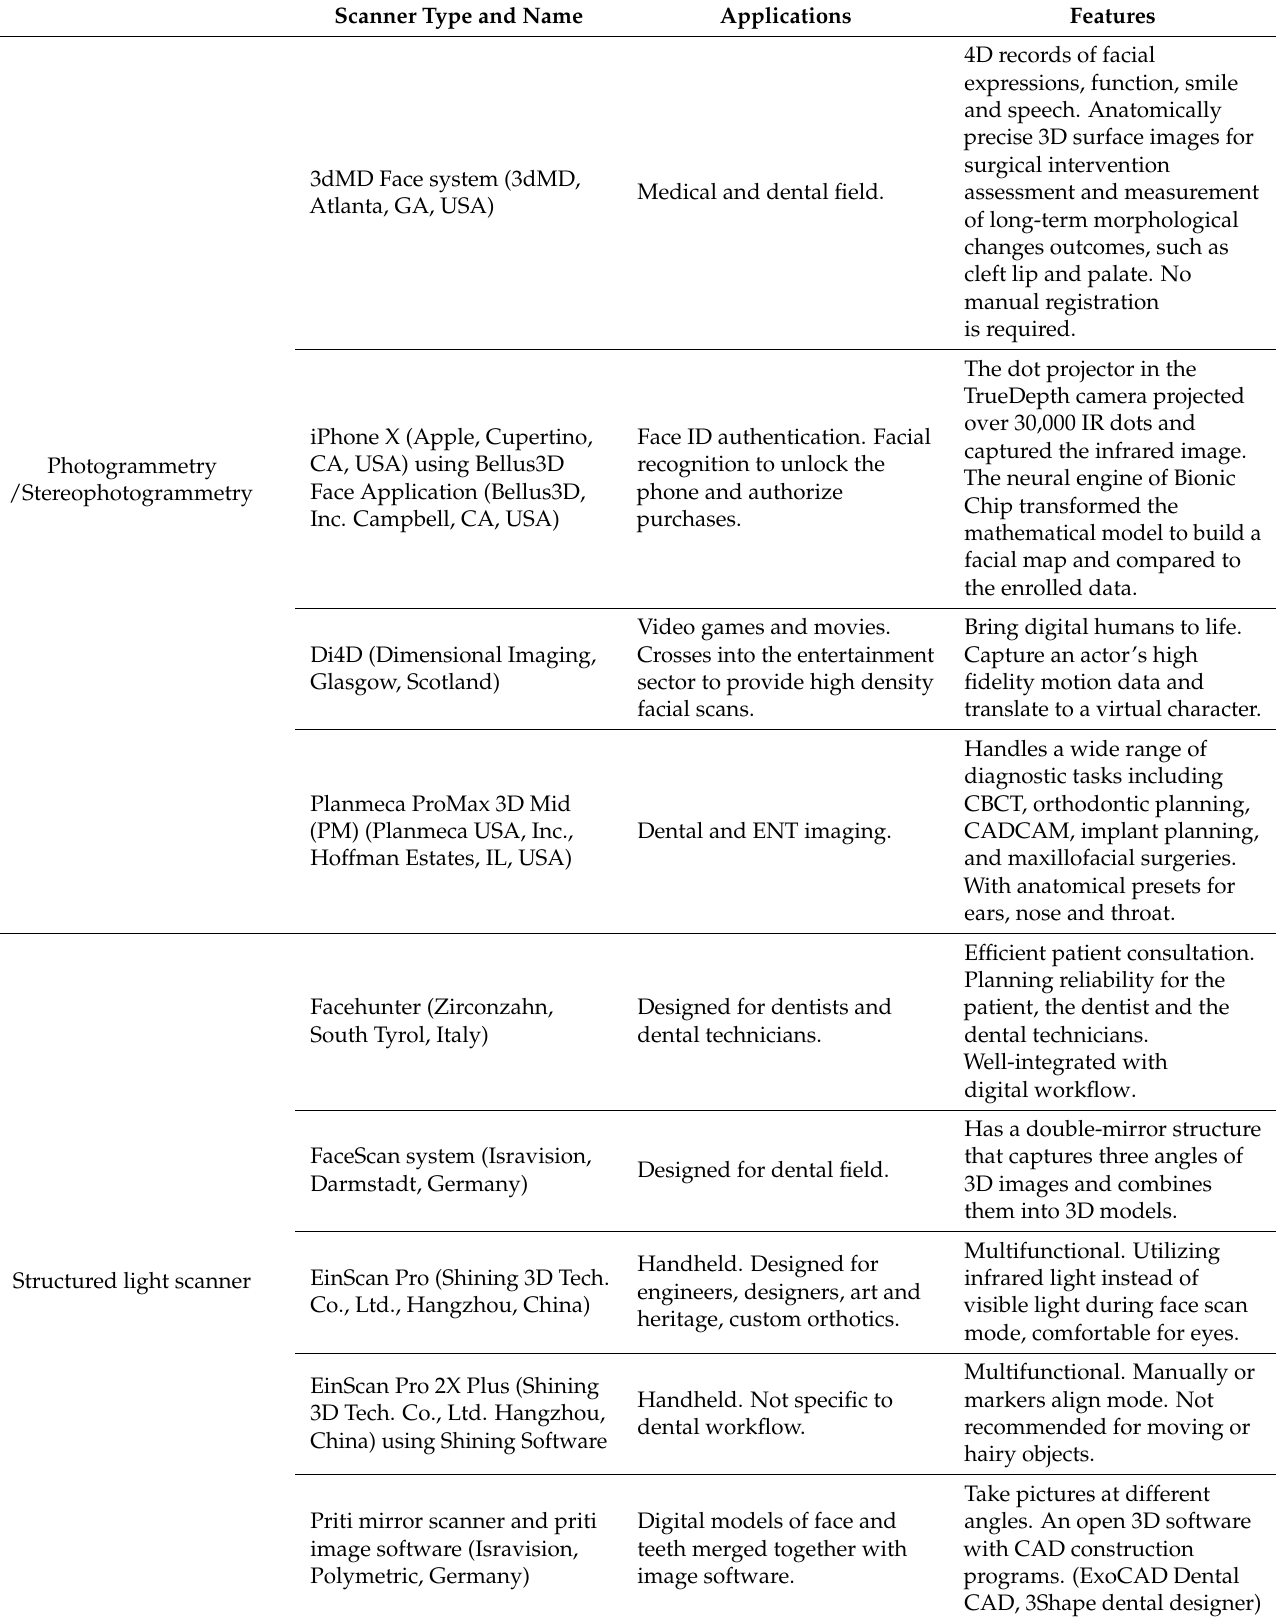
Table 1. List of available facial scanners & software (Features data obtained from manufacturers’